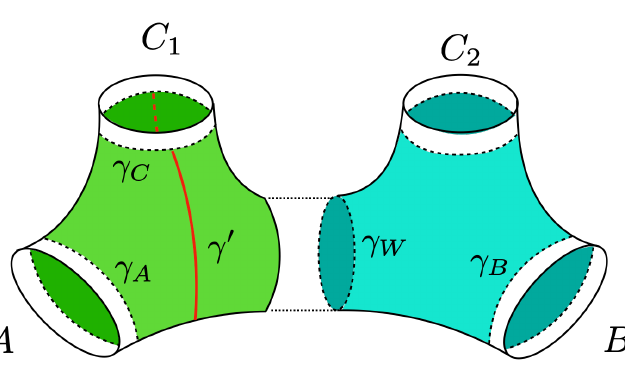
with area L . The surface γ was treated as the minimal i i W